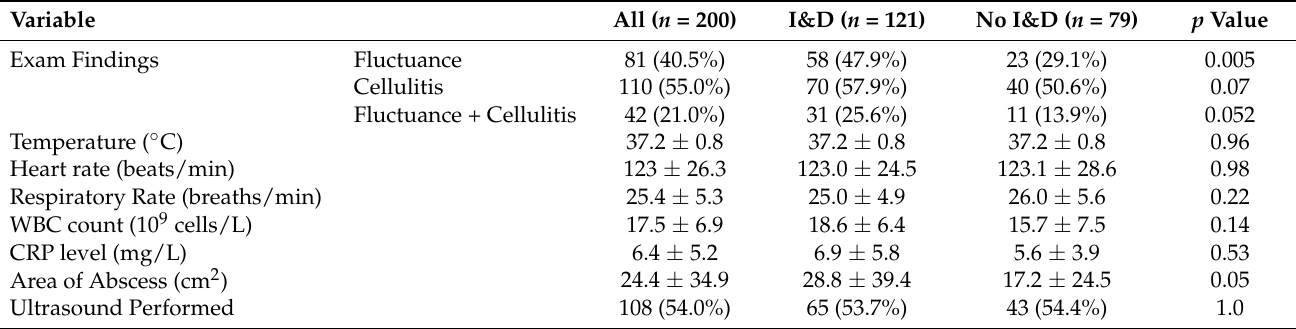
Figure 2. Bacteria identified in abscess wound cultures taken from abscesses. The most common bacteria identified was methicillin-resistant Staphylococcus aureus ( MRSA) followed by methicillin- sensitive Staphylococcus aureus. The remainder showed skin and enteric flora. Figure 1. Abscess area correlates with white blood cell count. A scatter plot representing the area